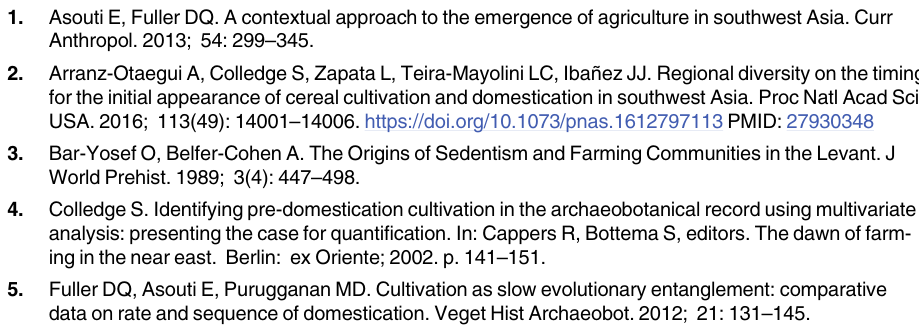
S11 Table. List of phytolith morphotypes identified and their frequencies (counts) in all grinding stone samples, giving sample information and sampling